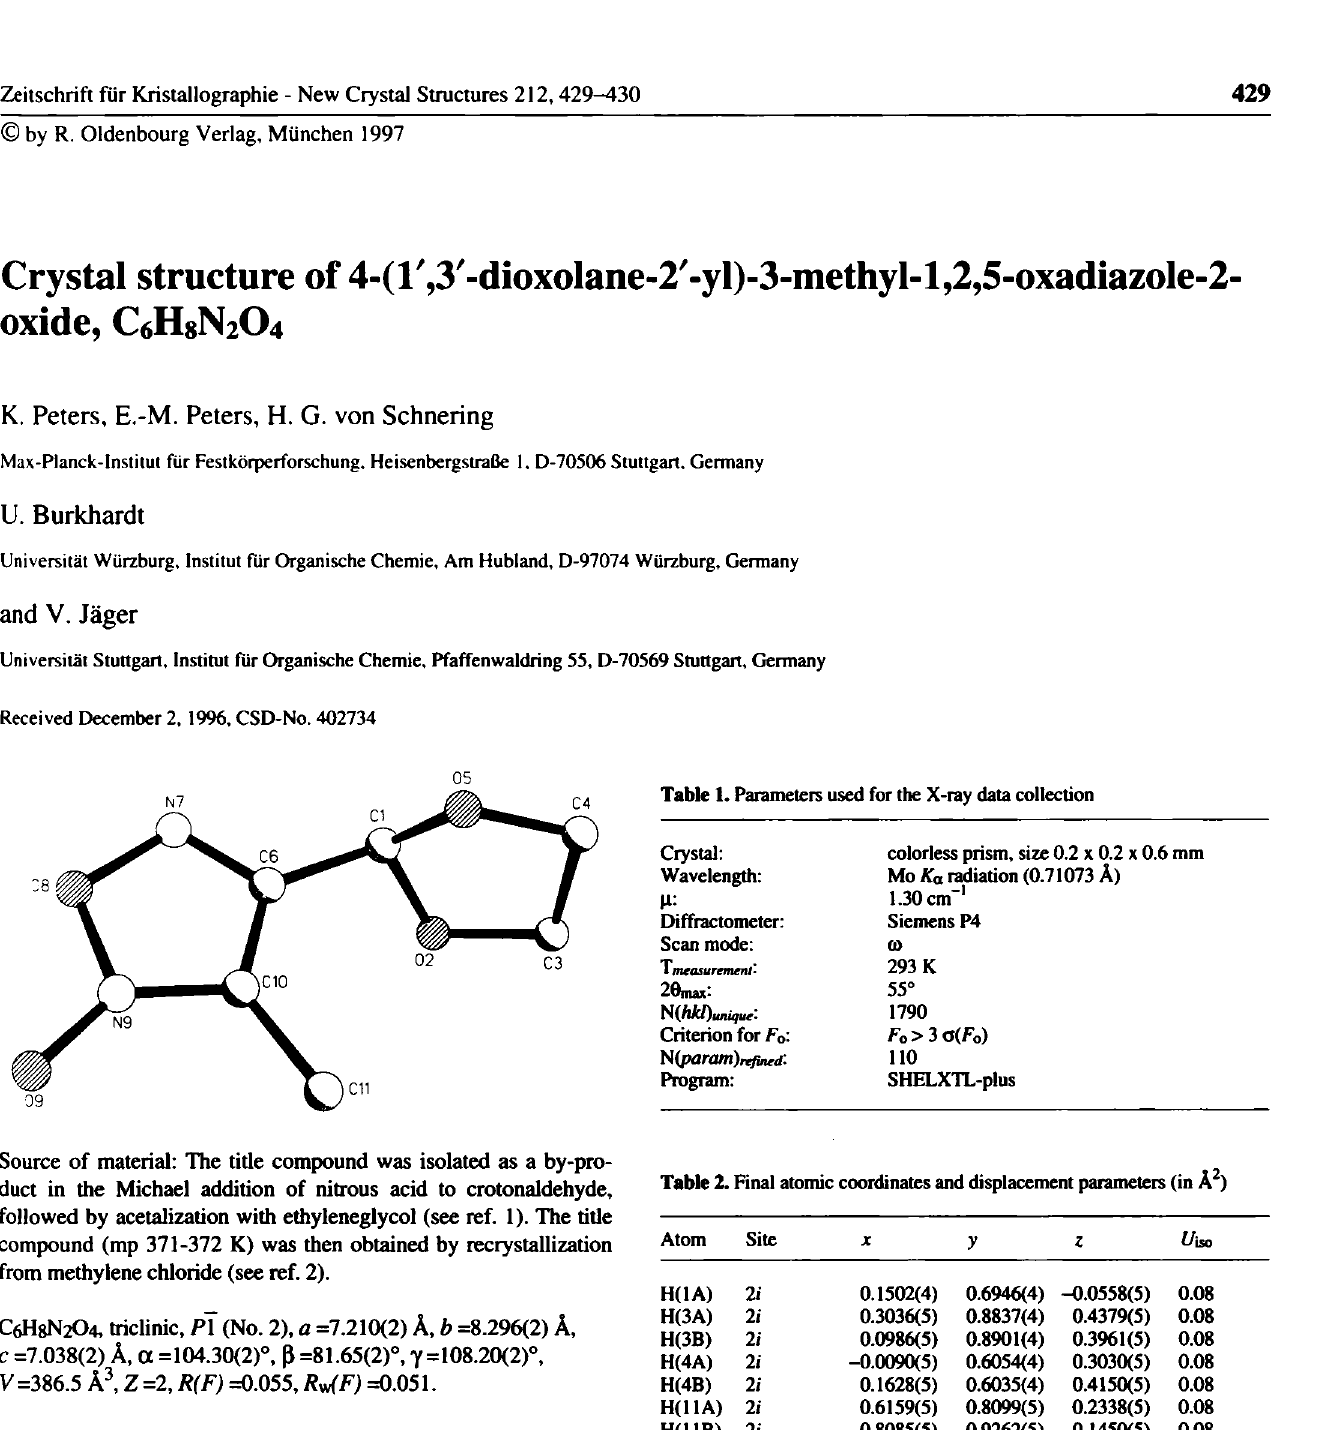
Table 3. Final atomic coordinates and displacement parameters (in Â 2